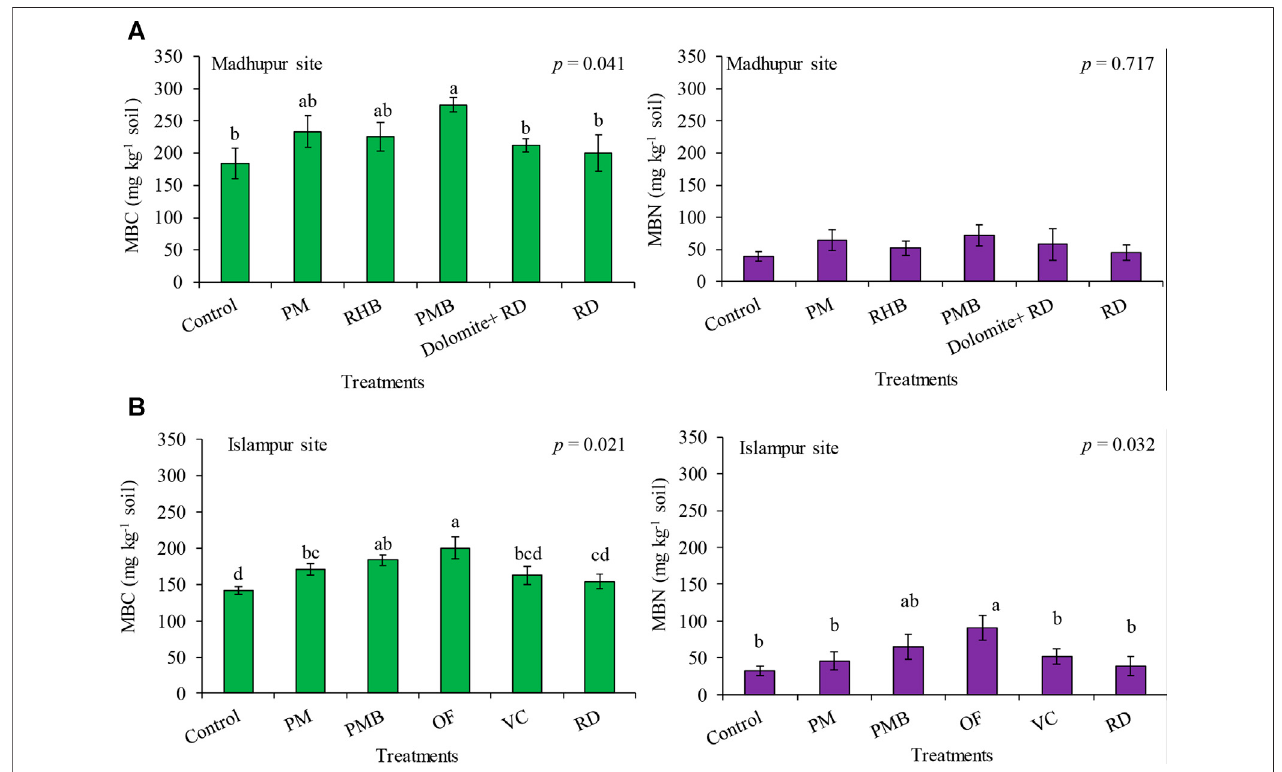
FIGURE1| Effects ofdifferentorganicand inorganic treatments on MBCand MBNatMadhupursite (A) and Islampur site (B) .Dataareaverage ± SE( n (cid:2) 4); PM (cid:2) poultry manure, RHB (cid:2) rice husk biochar, PMB (cid:2) poultry manure biochar, RD (cid:2) recommended dose only from chemical fertilizer, OF (cid:2) compost, VC (cid:2) vermicompost.